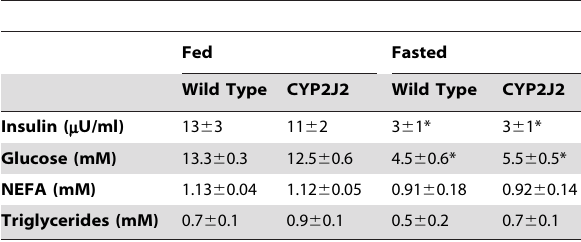
Table 1. Blood parameters in fed and fasted wild type and cardiac-specific CYP2J2 transgenic mice